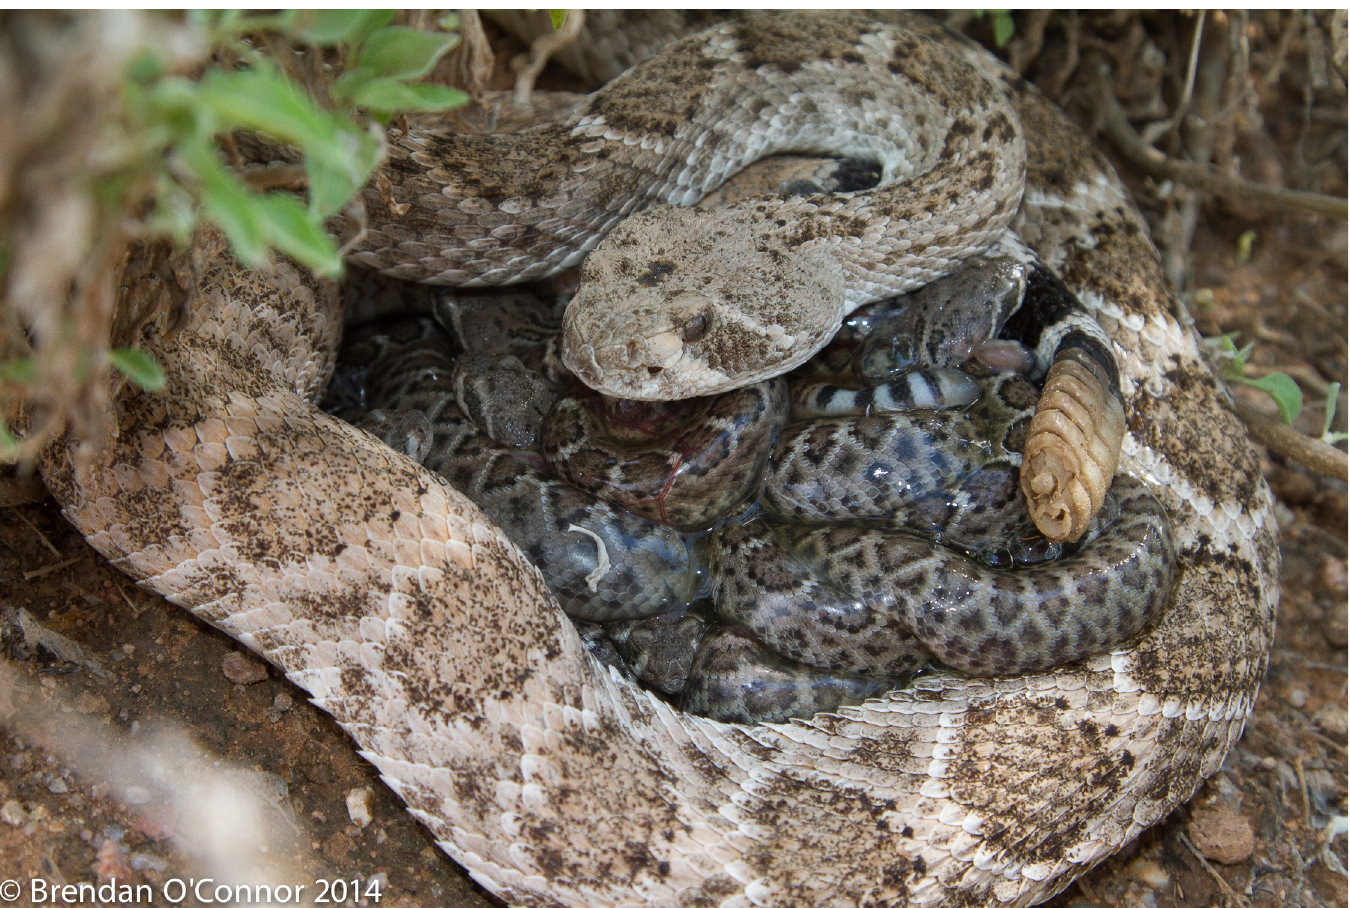
Fig 1. Female western diamond-backed rattlesnake, Crotalus atrox , with newborn offspring. Photograph courtesy of Brendan O’Connor.